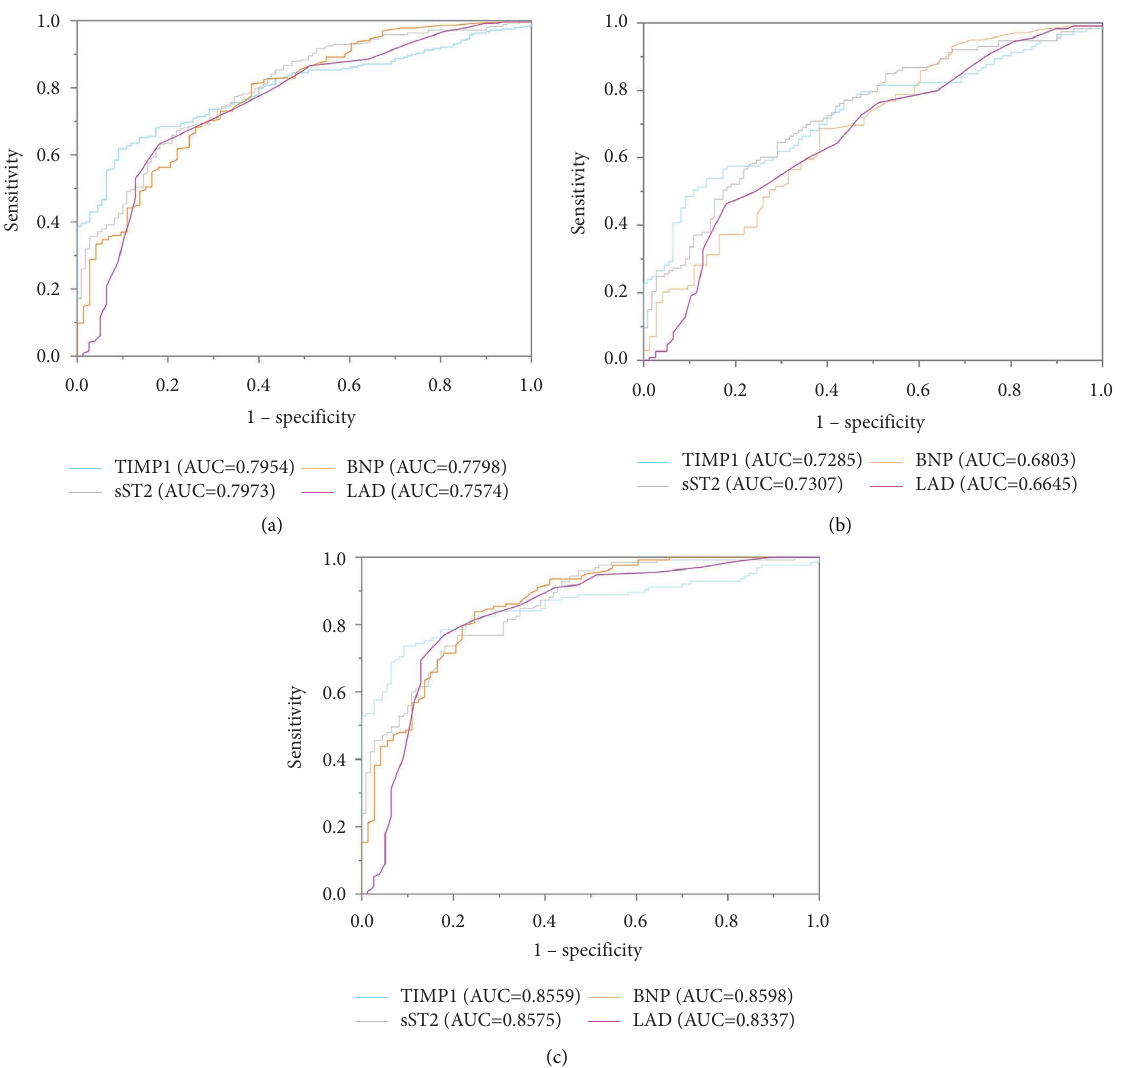
Figure 3: A receiver operator characteristic curve analysis for the progression of atrial fbrillation. (a) Sinus rhythm and atrial fbrillation. (b) Sinus rhythm and paroxysmal atrial fbrillation. (c) Sinus rhythm and persistent atrial